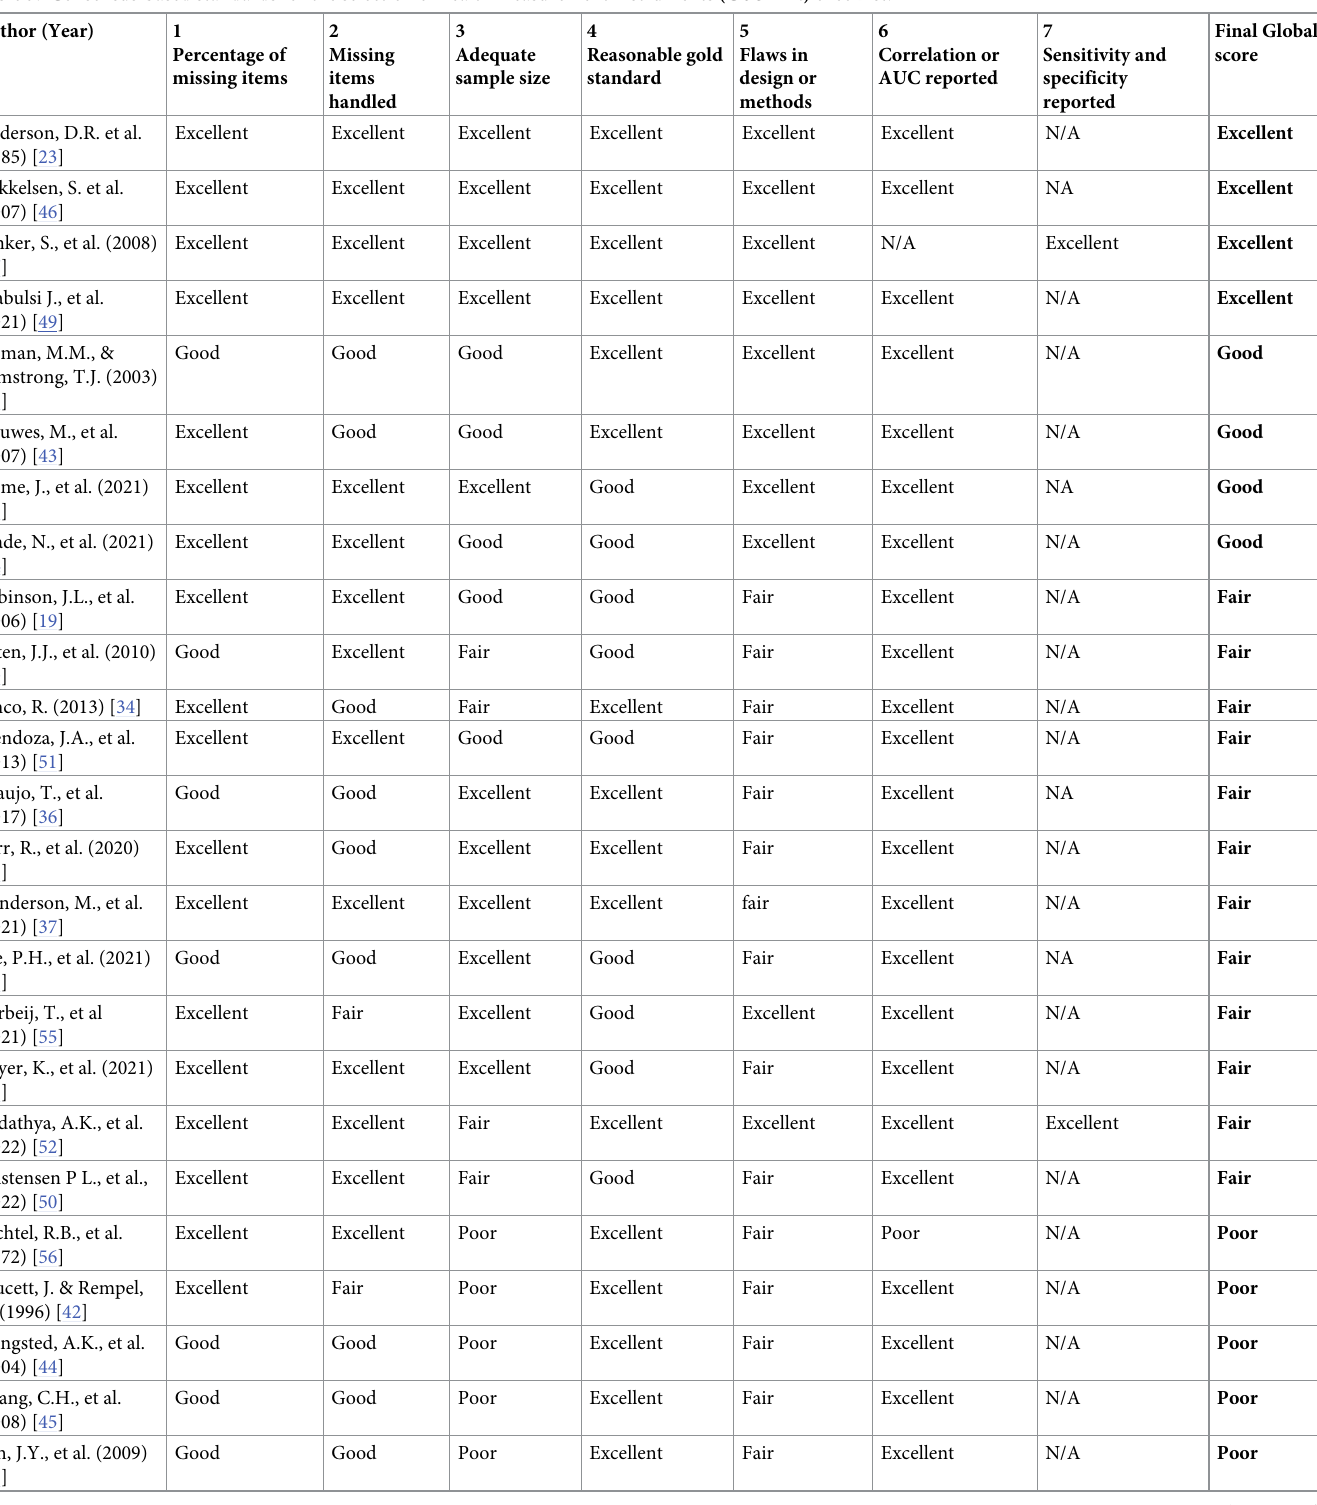
Table 3. Consensus-based standards for the selection of health measurement instruments (COSMIN)